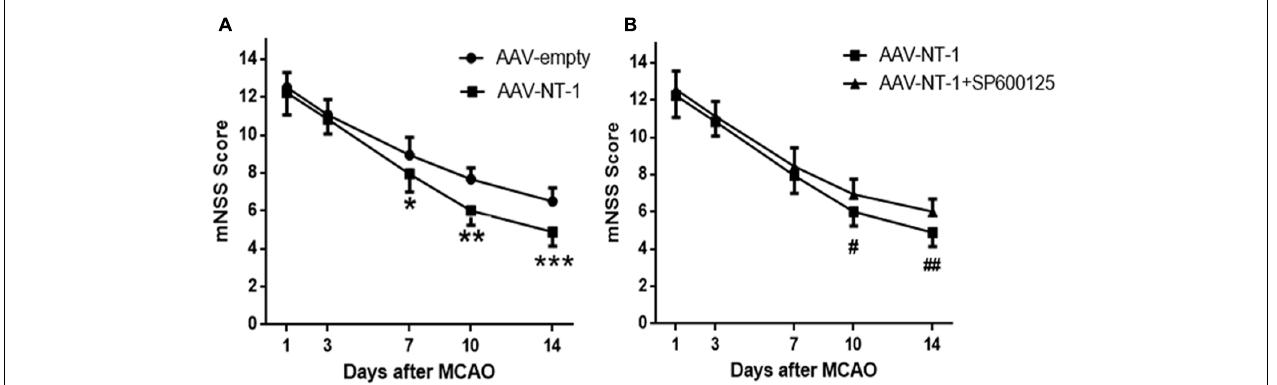
FIGURE 5 | Behavioral testing (mNSS). (A) Quantitative analysis of mNss scores. Rats in the AAV-NT-1 group reported significantly lower scores at Day 7, 10, and 14, ∗ p < 0.01, ∗∗ p < 0.001, ∗∗∗ p < 0.001, respectively, as compared with the AAV-empty group at the corresponding time points. (B) Quantitative analysis of mNss scores. Rats in the AAV-NT-1 group reported much lower scores at Day 10 and 14, # p < 0.001, ## p < 0.001, respectively, as compared with the AAV-NT-1+SP600125 group at the corresponding time points.